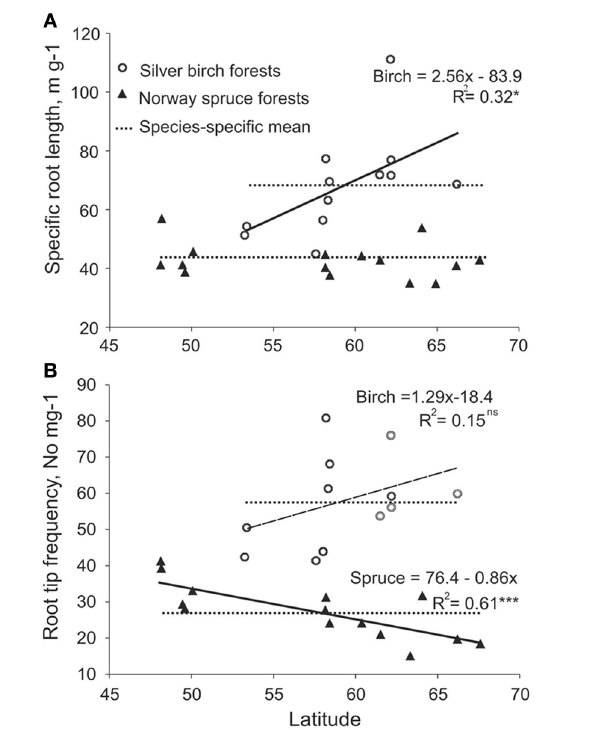
FIGURE 5 | Reaction norms of (A) specific root length and (B) root tip frequency permg EcM roots of spruce (filled triangles) and birch (open circles) across the latitudinal